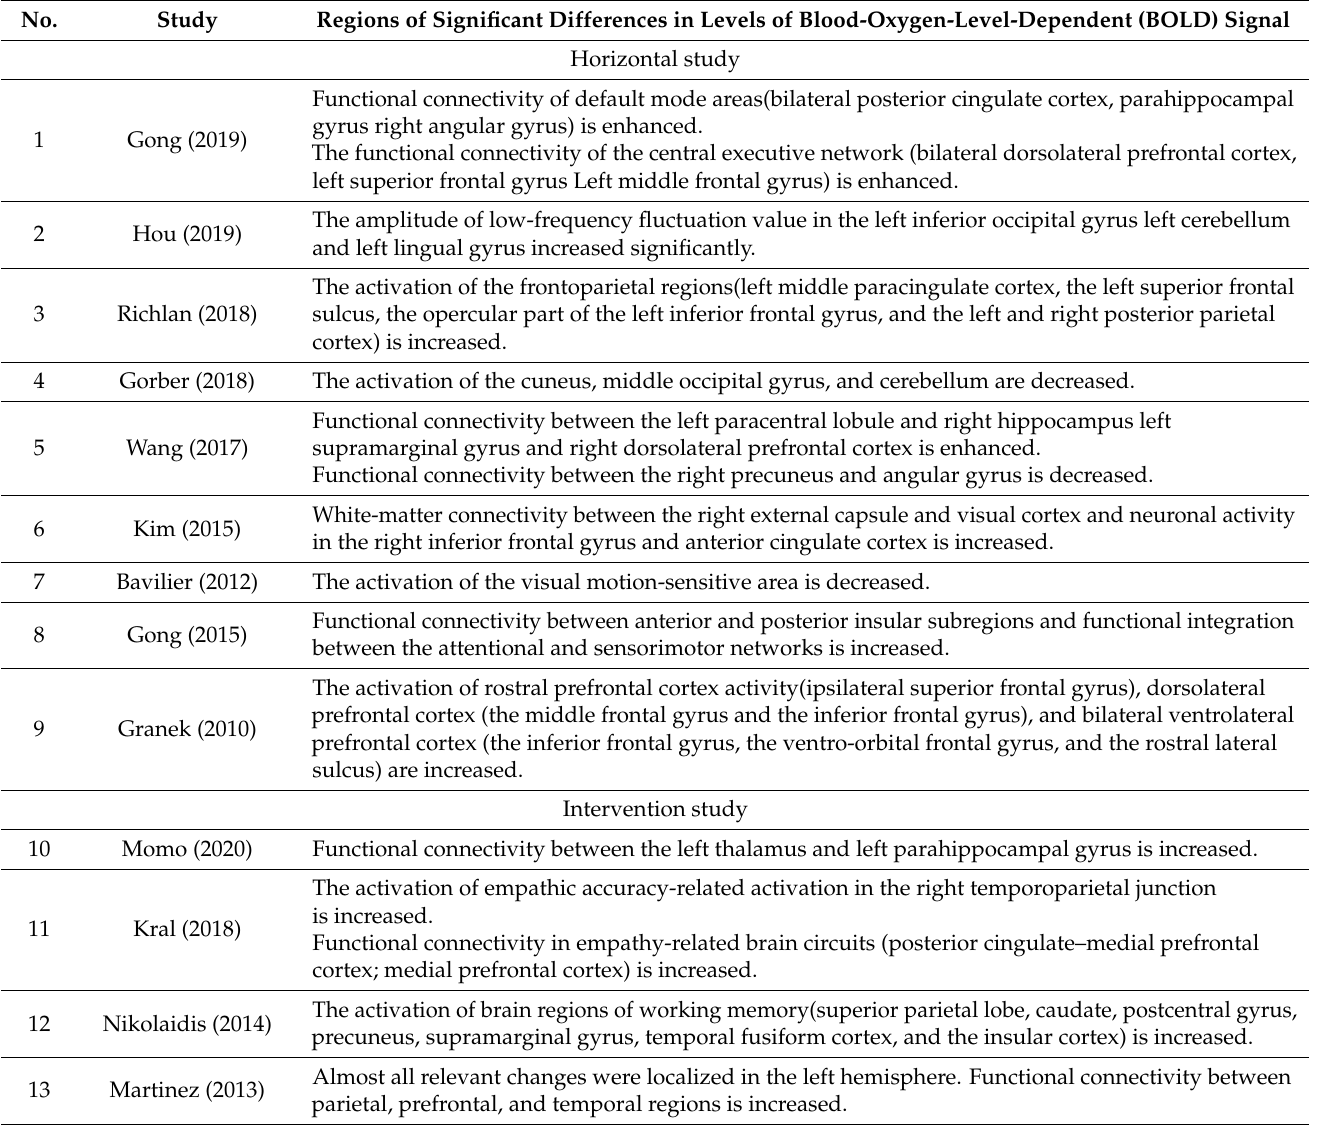
Table 2. Summary of brain activation